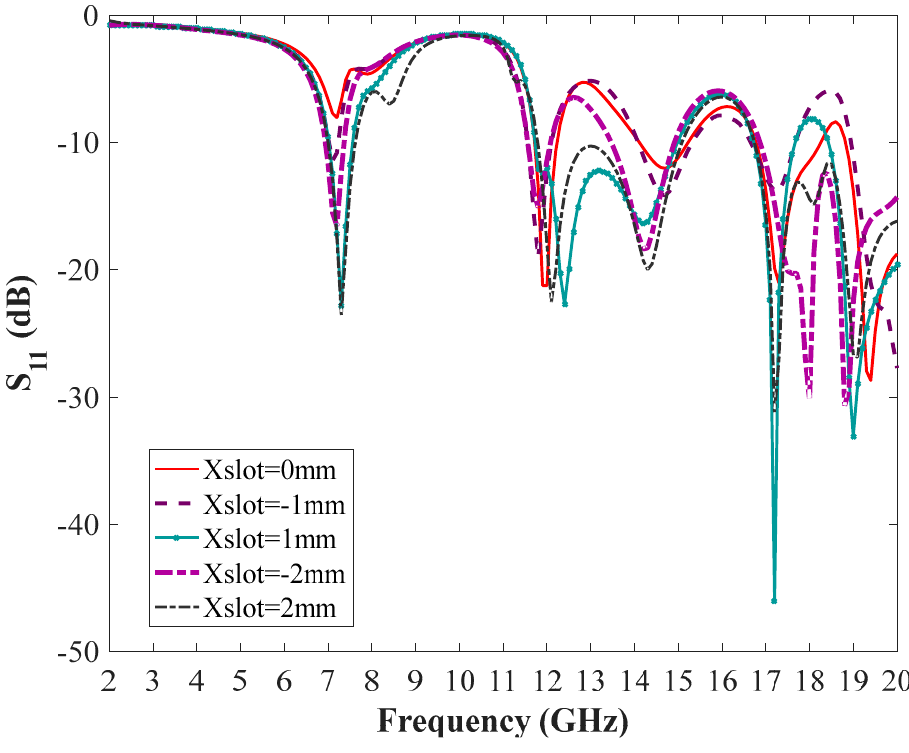
Figure 5. Finding the best coordination for Xslot on the patch with two slots being parallel to resonance edges.